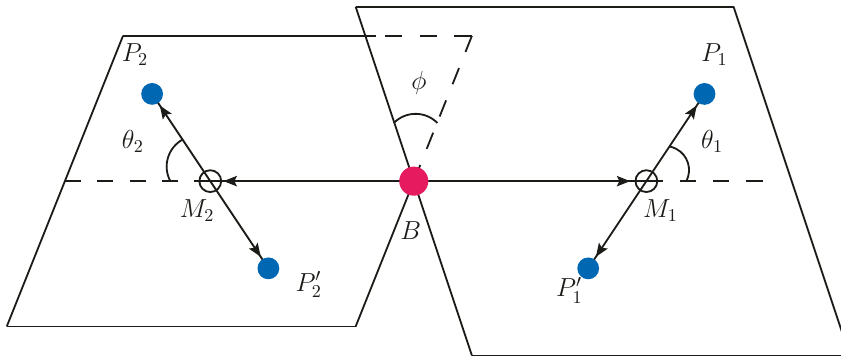
Figure 1 . Helicity angles θ 1 , θ 2 and φ for the B → M 1 M 2 decay, with each intermediate resonance decaying into two pseudoscalars, M 1 → P 1 P 0